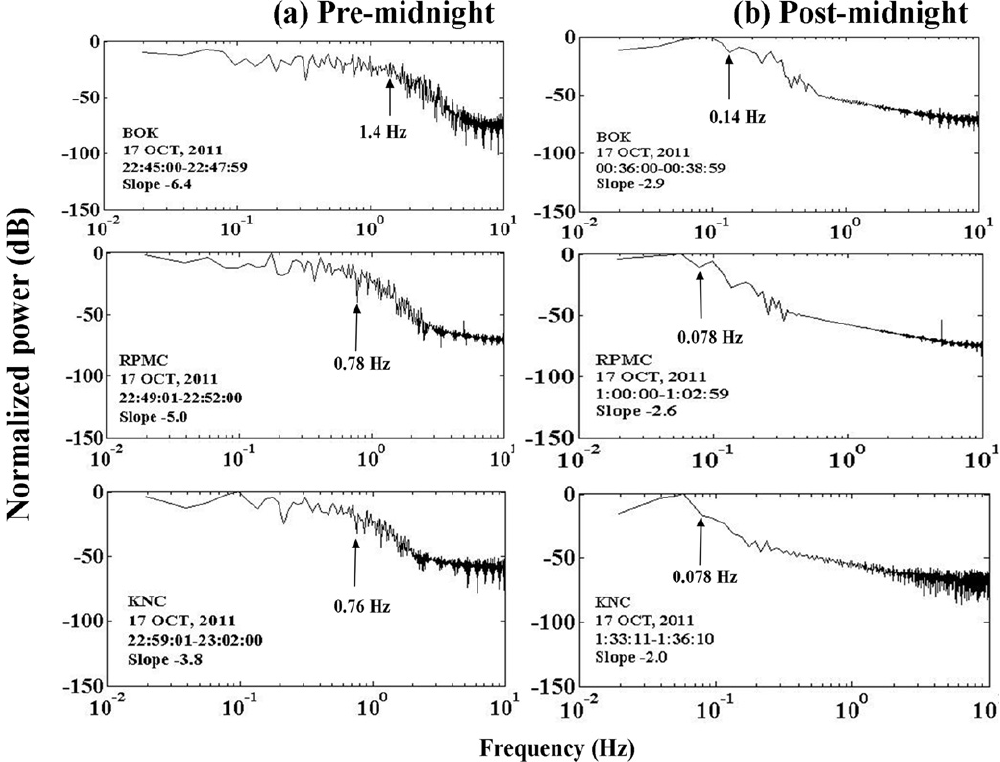
Fig. 7. Power spectra of (a) pre-midnight and (b) post-midnight amplitude scintillations (250MHz) as observed from BOK (uppermost panel), RPMC (middle panel) and KNC (lower most panel) on the date and time as mentioned in the diagram. Vertical arrows indicate corresponding break